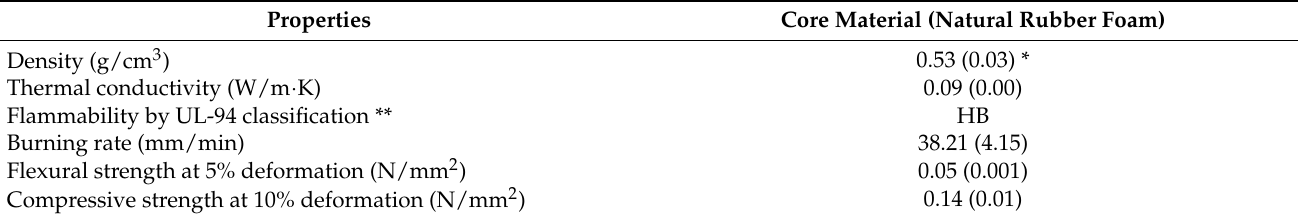
Table 5. Properties of the natural rubber foam used in this study.